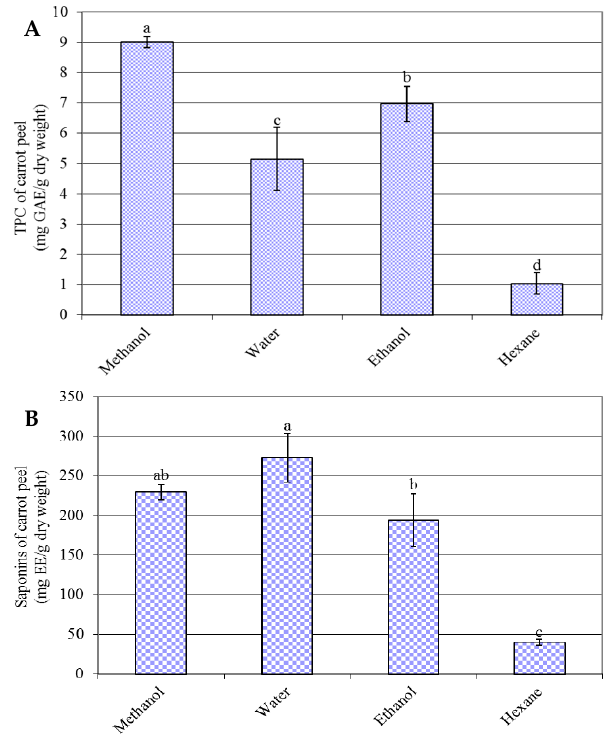
Figure 1. Total phenolic content ( A ) and saponin content and ( B ) of carrot peel extracted by four various solvents. Means and standard deviations were of triplicate. Different letters (a,b,c,d) within the columns denotes a significant difference between treatments ( p < 0.05)